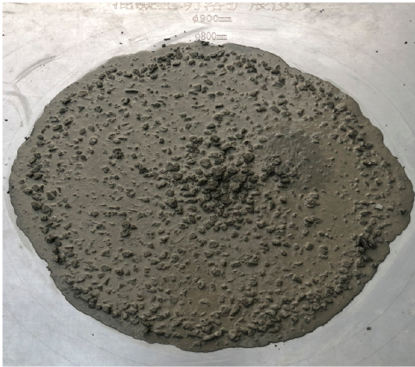
Figure 5. The extending properties of self-compacting concrete (SCC).